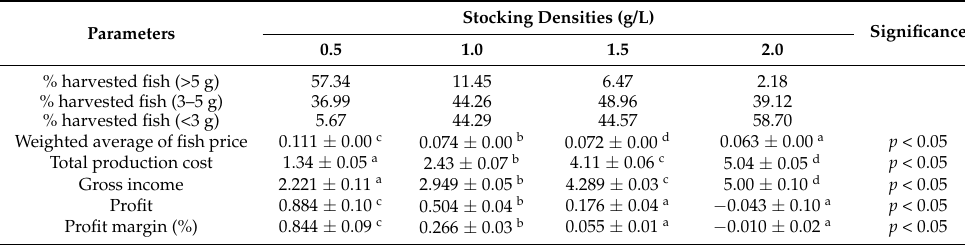
Table 5. Profitability analysis of O. bimaculatus seed in biofloc system at different stocking densities considering fish sold at three different prices as per harvested weight (>5 g, USD 0.13 per piece; 3–5 g, USD 0.09 per piece; <3 g, USD 0.04 per